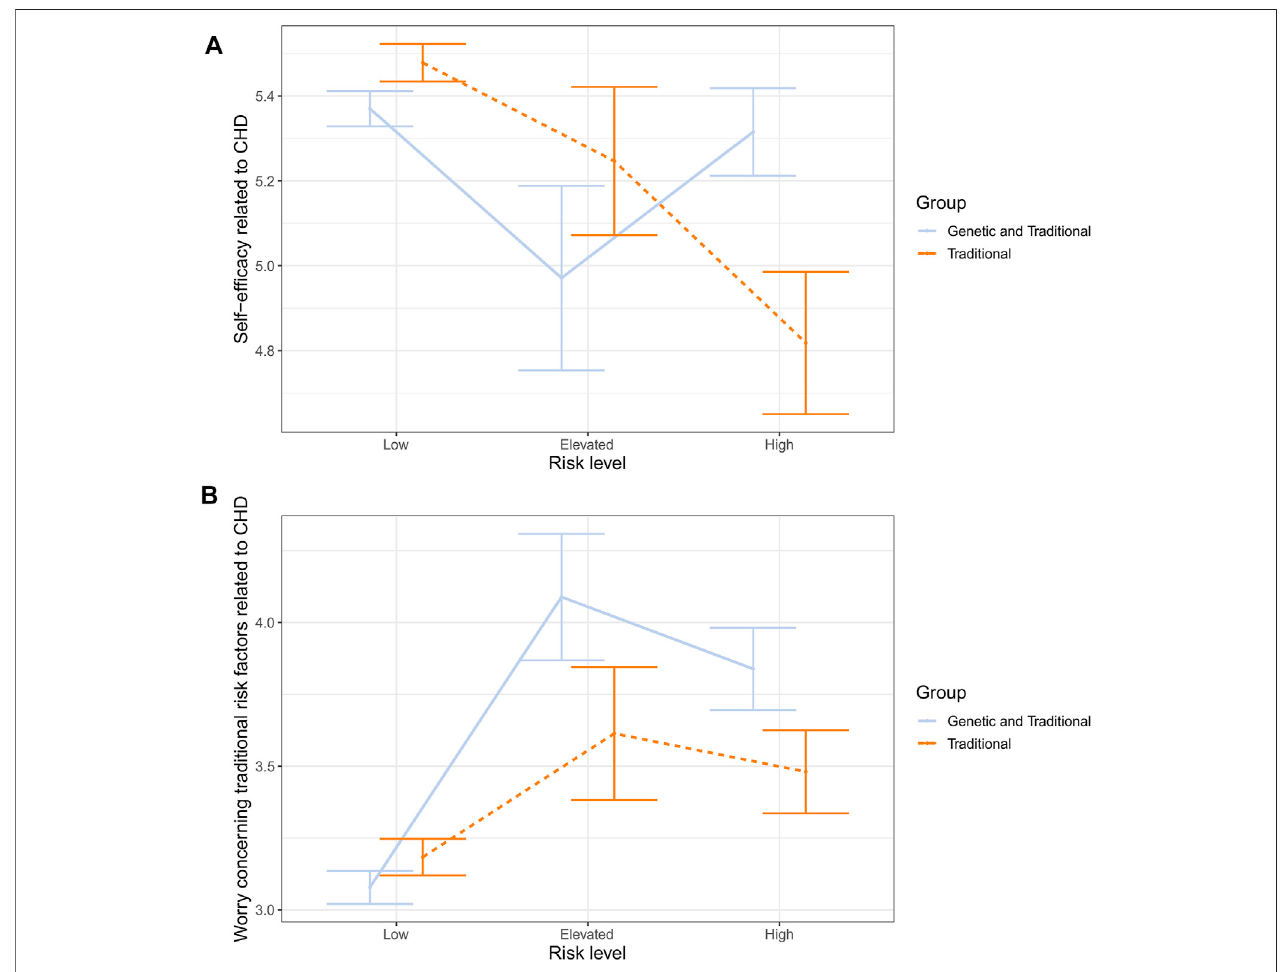
FIGURE 2 | Estimated means and standard errors for interaction between risk type and risk level concerning CHD related self-ef fi cacy (A) and worry (B) .